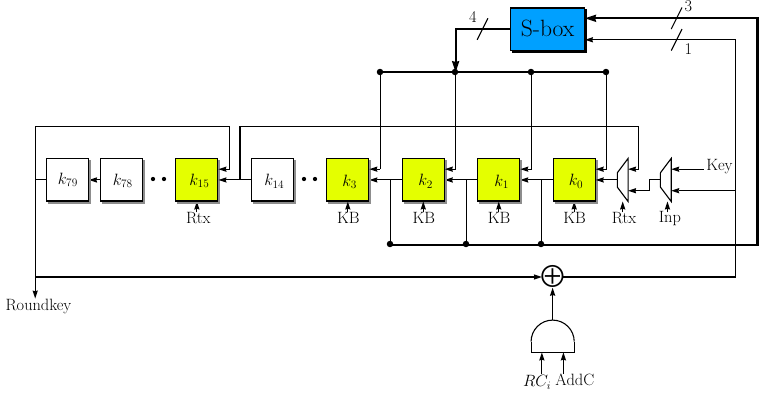
Figure 4: The PRESENT